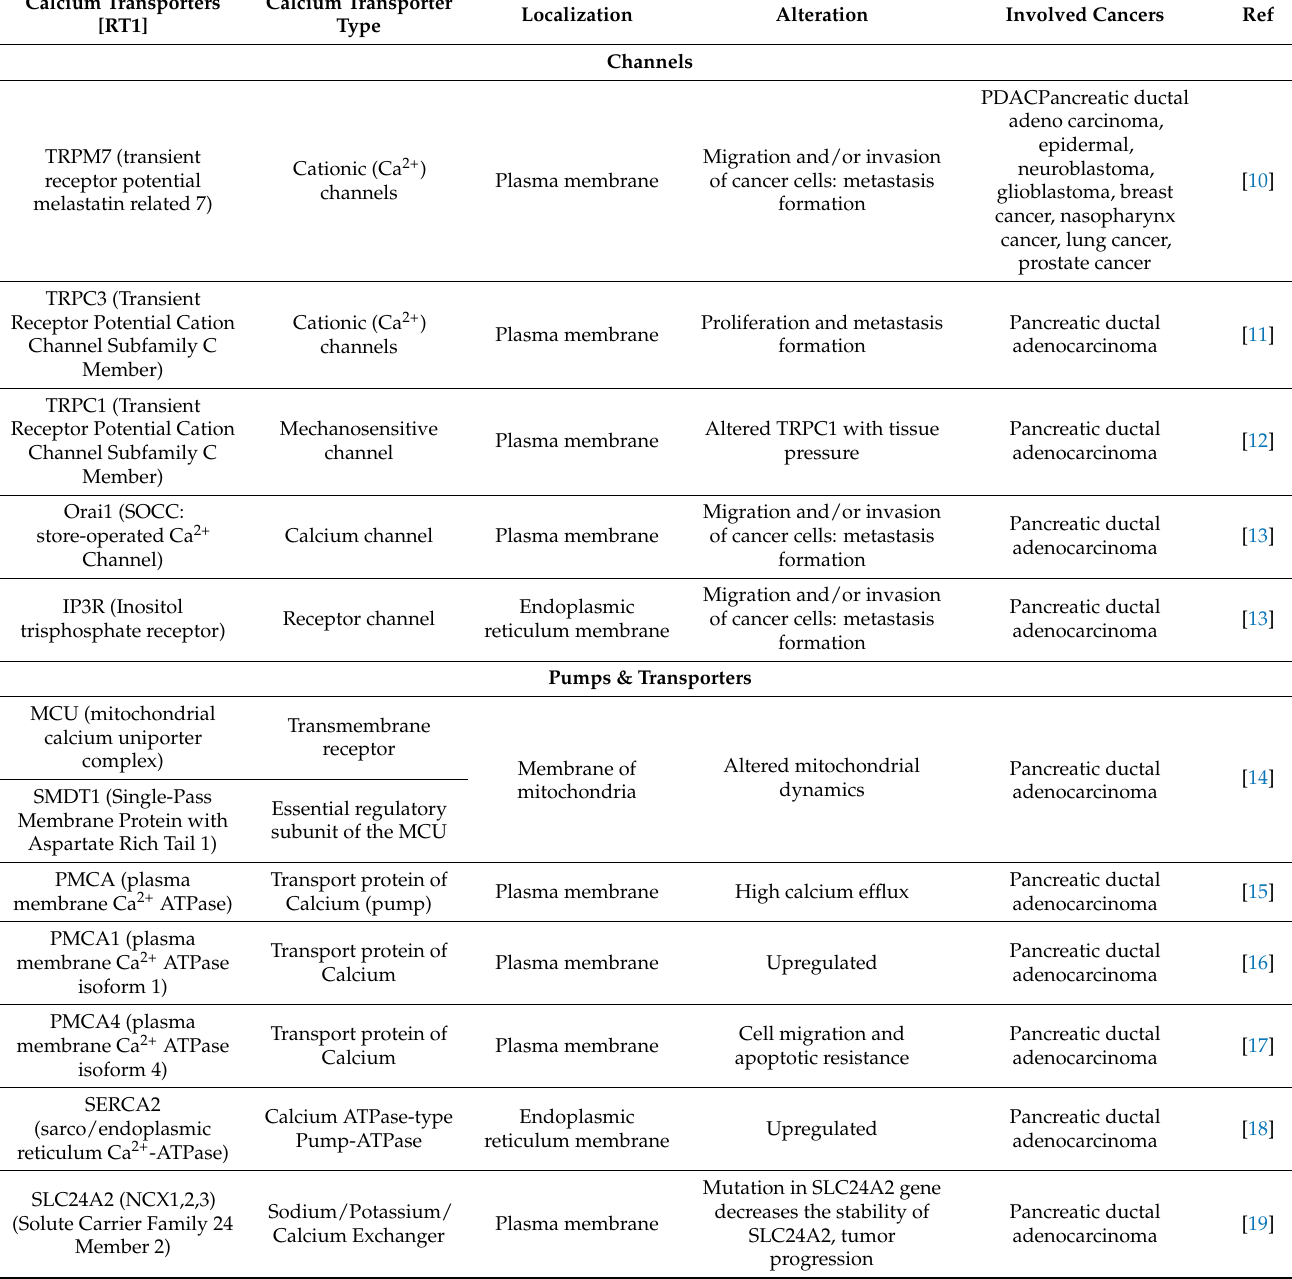
Table 1. Expression, localization, and the potential role of calcium transporters in pancreatic ductal adenocarcinoma (PDAC). Calcium Transporters